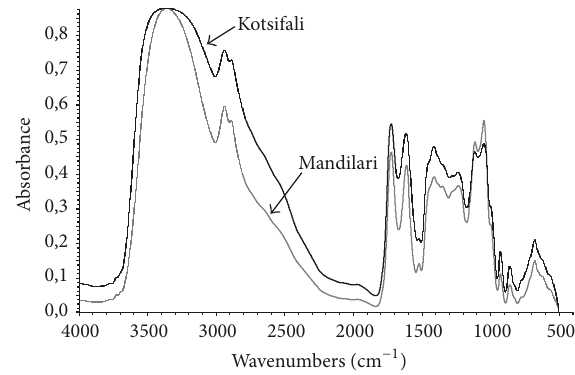
Figure 2: Typical FT-IR spectra for Kotsifali and Mandilari